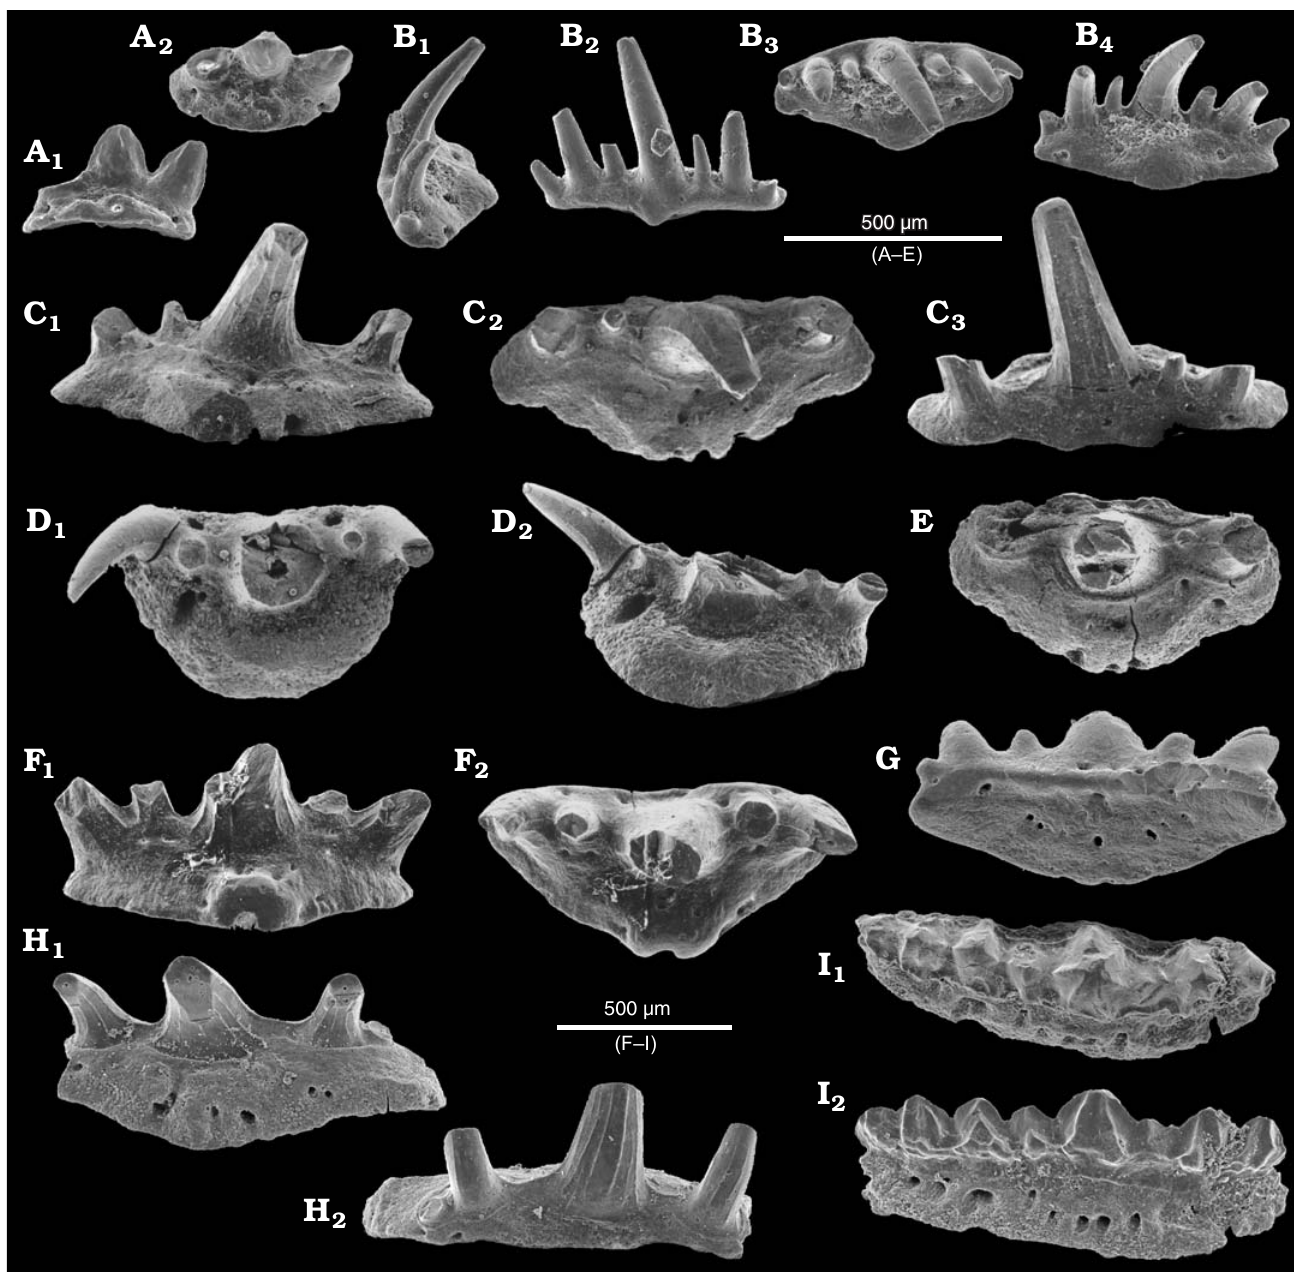
Fig. 3. Chondrichthyan fish teeth from the Tournaisian of Czatkowice, Poland. A . Jalodus sp., MWGUW/Ps/13/2, in lingual (A 1 ) and oral (A 2 ) views. B–H . Falcatidae indet. 1. B . MWGUW/Ps/13/3, small seven-cuspid specimen in lateral (B 1 ), labial (B 2 ), oral (B 3 ), and lingual (B 4 ) views. C–F . Large five-cuspid specimens. C . MWGUW/Ps/13/4 in lingual (C 1 ), oral (C 2 ), and labial (C 3 ) views. D . MWGUW/Ps/13/5 in oral (D 1 ) and lingual (D 2 ) views. E . MWGUW/Ps/13/6 in oral view. F . MWGUW/Ps/1/221 in lingual (F 1 ) and oral (F 2 )views. G . MWGUW/Ps/13/7, large seven-cuspid specimen in basal/ labial view. H . MWGUW/Ps/13/8, large five-cuspid specimen without the intermediate cusplets in lingual (H 1 ) and labial (H 2 ) views. I . Protacrodontidae indet., MWGUW/Ps/13/9, in oral (I 1 ) and lingual (I 2 )